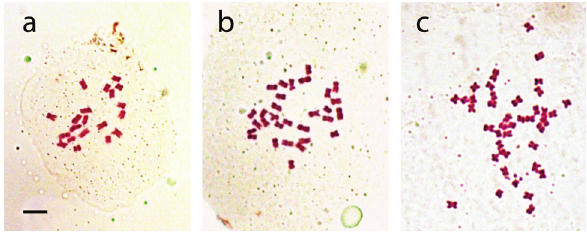
Figure 1 - Mitotic metaphases from different Paspalum modestum plants. (a) diploid cell with 2 n =2 x =20 chromosomes. (b) triploid cell with 2 n =3 x =30 chromosomes. c: tetraploid cell with 2 n =4 x =40 chromosomes. The scale bar represents 5 (cid:3) m.